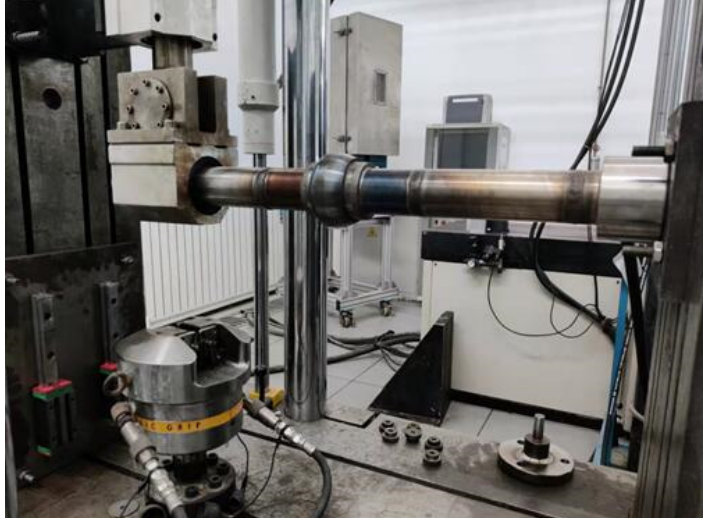
Figure 3. Test platform.